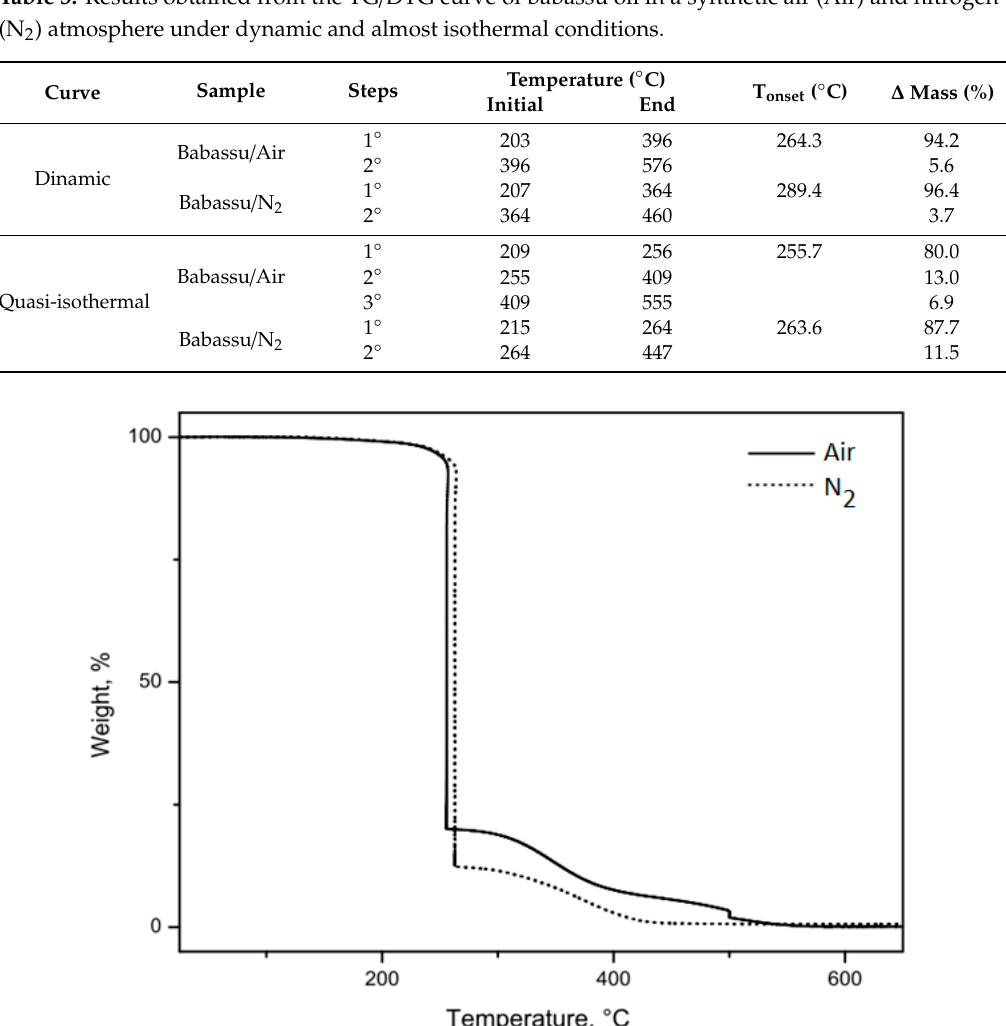
Figure 3. TG / DTG curve: Mass loss of babassu oil in an oxidative atmosphere of synthetic air and nitrogen under almost quasi-isothermal conditions.